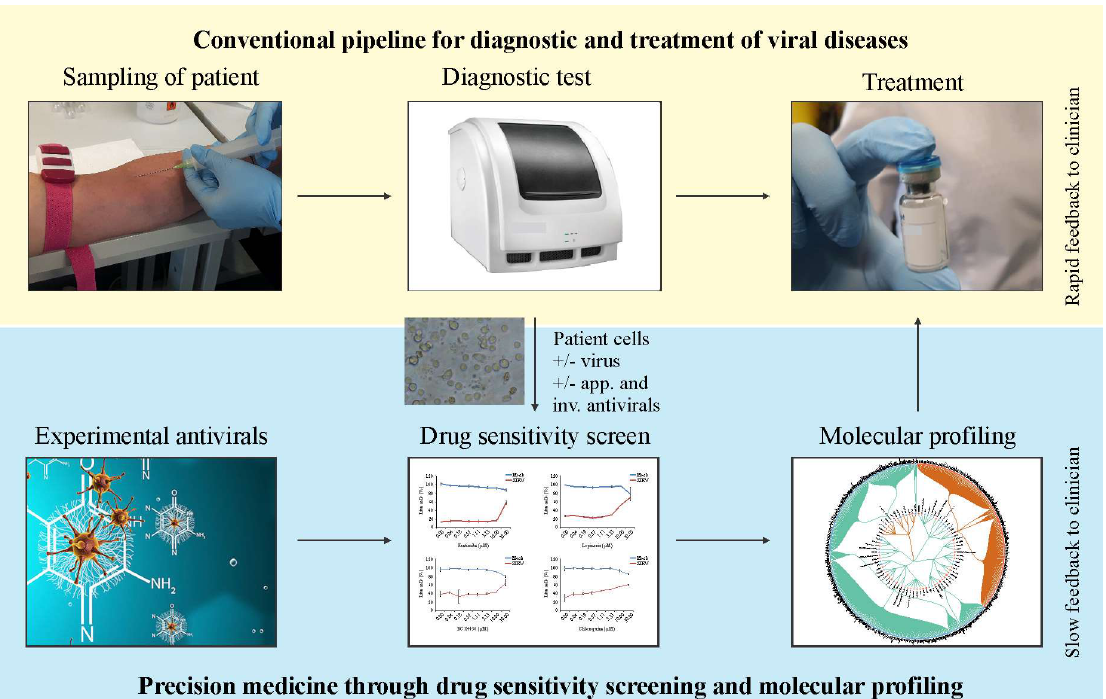
Figure 6. Added value of the systems approach. Systems approaches will guide the evaluation of novel antivirals and their side effects and implementation into personalized medicine pipeline.